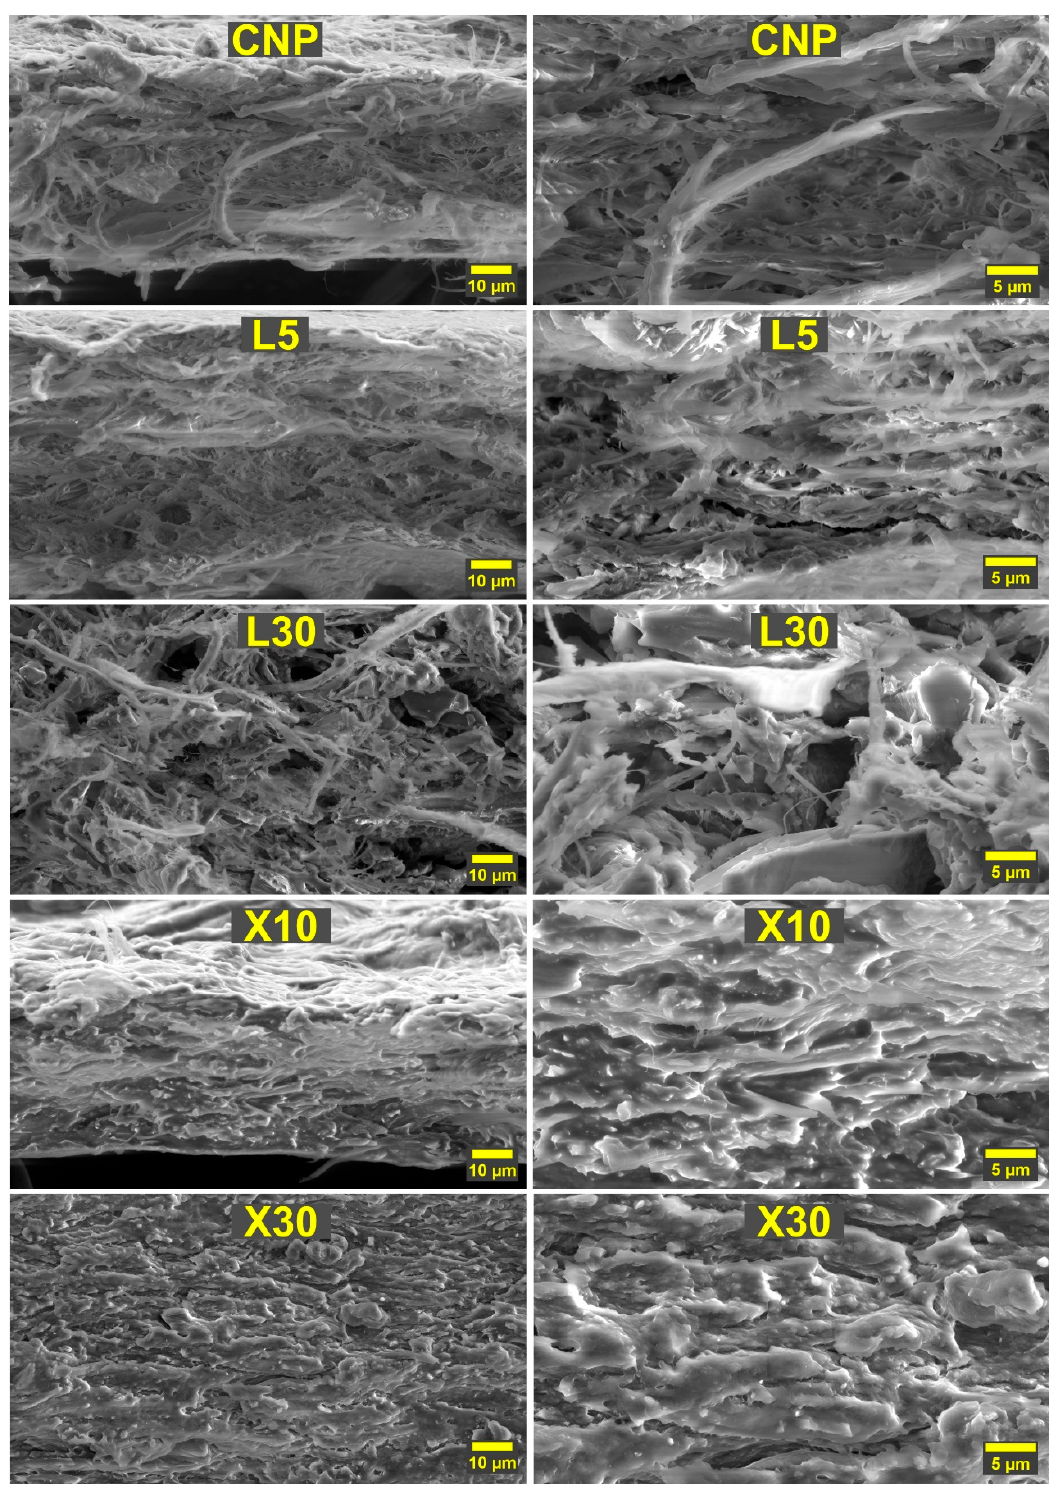
Figure 6. Cross ‐ section scanning electron micrographs of selected NP compositions. Figure 6. Cross-section scanning electron micrographs of selected NP